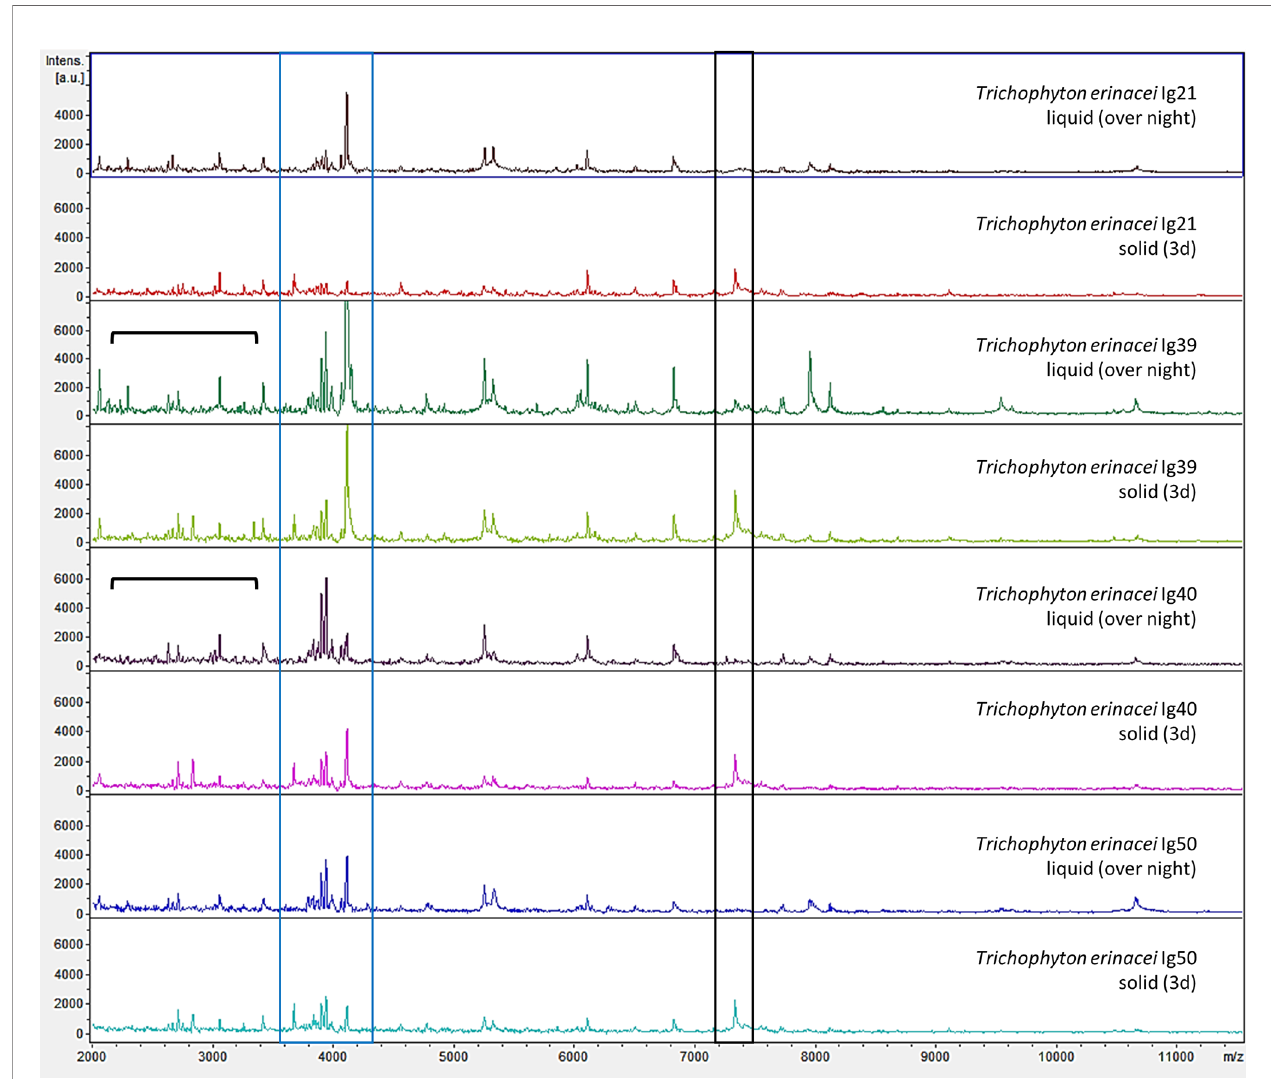
FIGURE 4 | Examples of mass spectrometric pro fi les (raw spectra) of different Trichophyton (T.) erinacei -isolates cultured in liquid Sabouraud-2% Dextrose-broth over-night with gentle rotation at room temperature (liquid, over-night) and on solid agar plates for 3d at 28°C (solid, 3d) are shown. Species identity was con fi rmed by sequencing of the ITS region of fungal rDNA. Overall, the mass spectrometric pro fi les were very similar for both cultivation methods. For some isolates grown in liquid media, more and/or more intense peaks were observed in the lower mass range (indicated by the black parenthesis). On the other hand, a peak at around 7300 m/z (black box) was predominantly found in solid cultures. However, a cluster of peaks around 4000 m/z (blue box) seems somewhat species speci fi c for T. erinacei since it was found in most examined isolates regardless of the cultivation